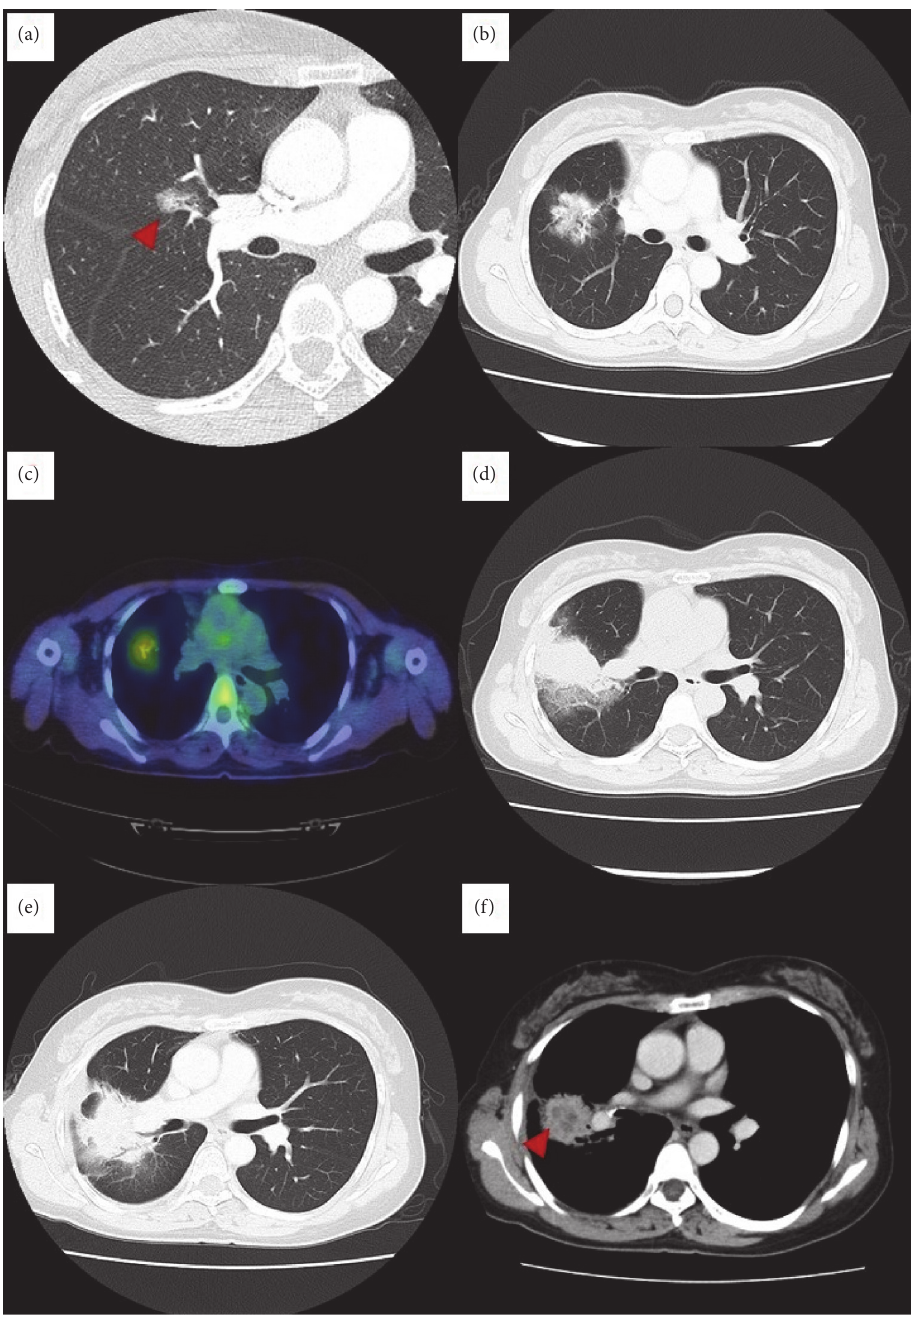
Figure 1: Chest computed tomography images. (a) A part-solid GGN on the middle lobe of the right lung. This portion of the GGN invades the upper lobe. (b) Three years and two months after the lung surgery, a mass emerges adjacent to the staple line. (c) Fluorodeoxyglucose PET-CT. The maximum standardized uptake value is 2.64. (d) Two months after the end of radiation therapy, ground-glass attenuation surrounding the mass and an increase in mass size are detected. (e) Five months after the end of radiation therapy, the mass shows continuous growth. (f) Five months after the end of radiation therapy, contrast-enhanced CTshowed internal low absorption suspected of